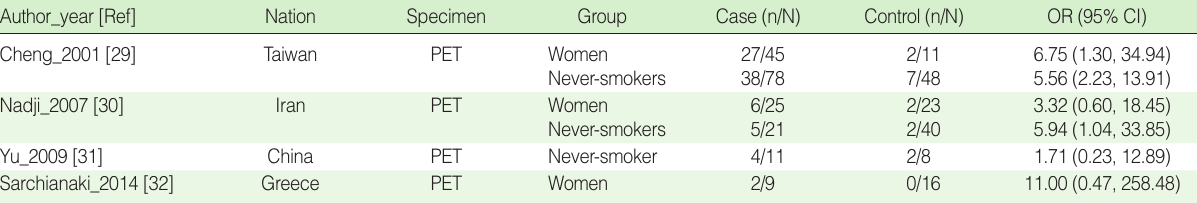
Table 1. Summary of four selected case-control studies for association of HPV 16/18 infection with lung cancer in women and never-smokers